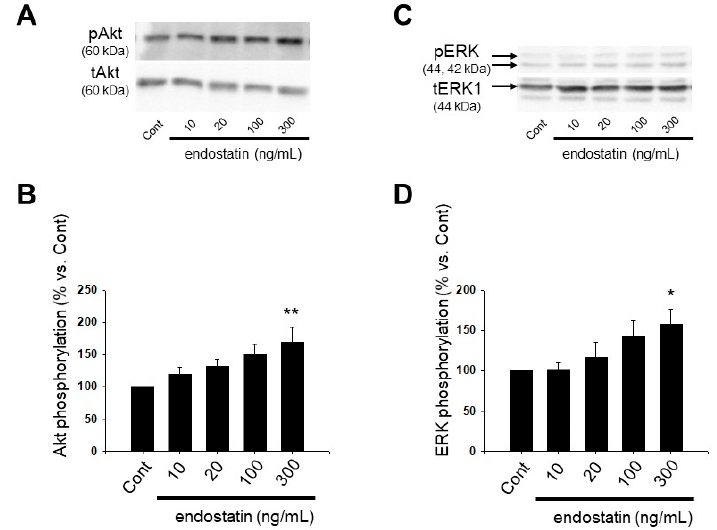
Figure 3. Endostatin induced phosphorylation of Akt and extracellular signal-regulated kinase (ERK) in myofibroblasts. Myofibroblasts were stimulated with endostatin (10–300 ng/mL, 60 min) or vehicle, and cell lysate was collected. Phosphorylation of Akt (at Ser473: A , B ) and ERK ( C , D ) was detected by Western blotting. ( A , C ) Representative blots of phosphorylated proteins (pAkt: A pERK: C ) and total proteins (tAkt: A ; tERK1: C ) for Akt and ERK are shown; ( B , D ) Levels of phosphorylated proteins were corrected by total proteins, and the normalized expression relative to Cont are shown as mean ± S.E.M. (Akt: n = 12, ERK: n = 11). *, p < 0.05, **, p < 0.01 vs. Cont.